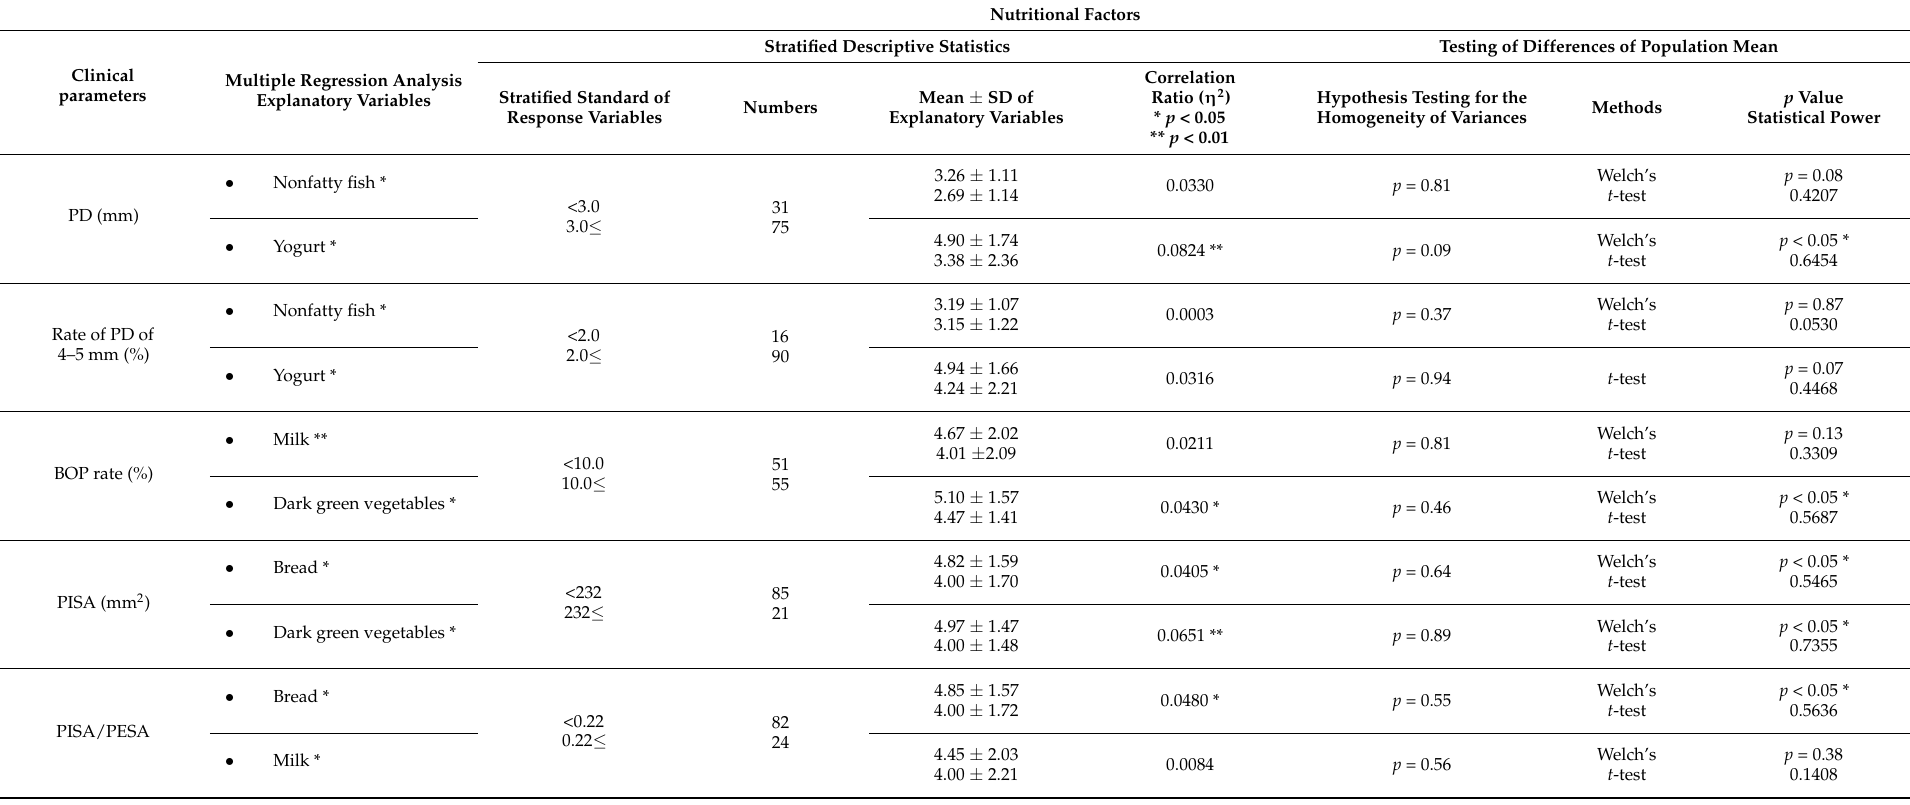
Table 4. Stratified descriptive statistics between clinical parameters and environmental